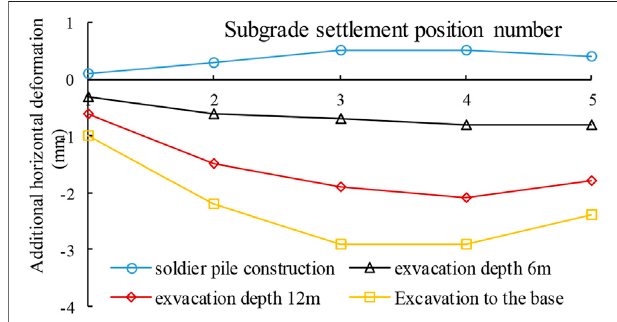
FIGURE 6 | Cumulative lateral horizontal deformation of the subgrade.